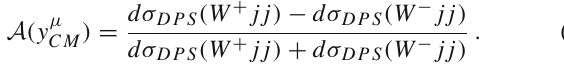
T A correspond to central (peripheral) events, with the ratio increasing going from peripheral to central collisions. The errors associated to the distribution determine a marked sen- sitivity to DPS2 mechanism which is responsible for the non zero slope of the